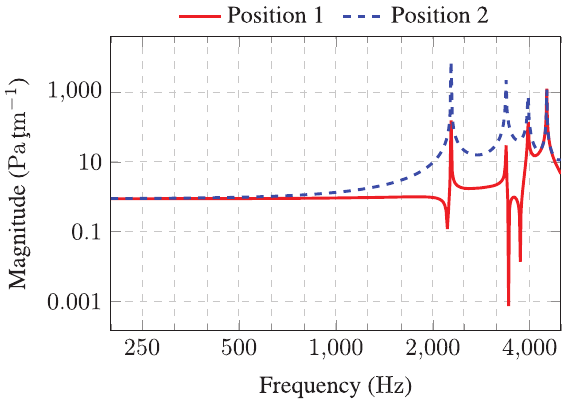
Figure 12. Simulated transfer function between rear micro- phone pressure and membrane displacement